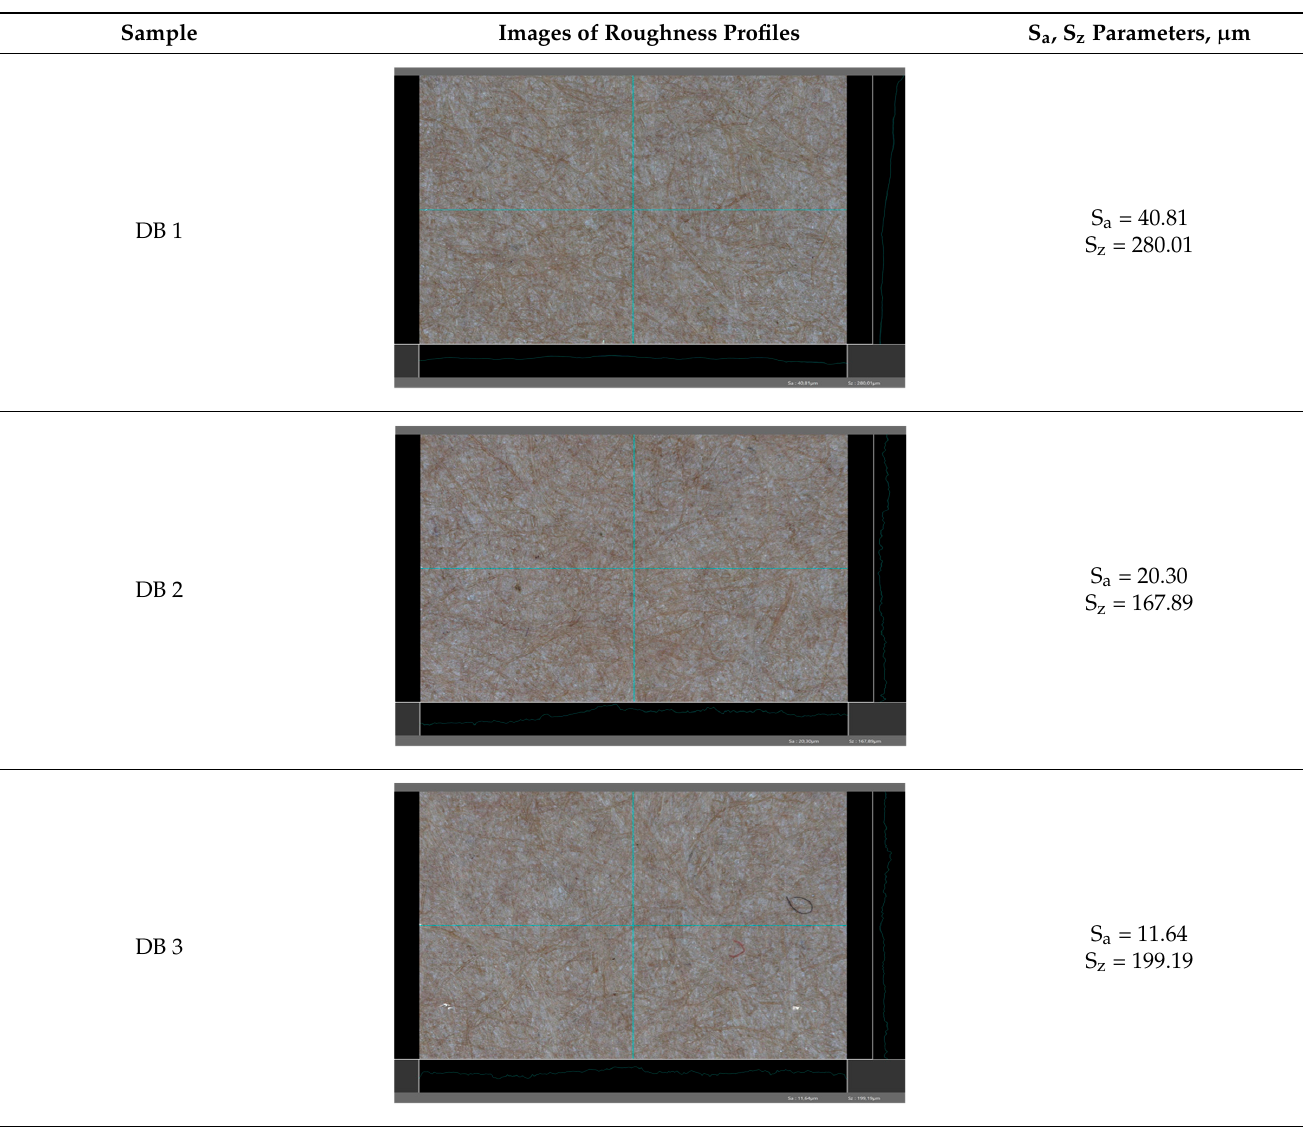
Table 6. Sensory evaluation of the dispersion samples (before the coating process) and properties of the coated papers.